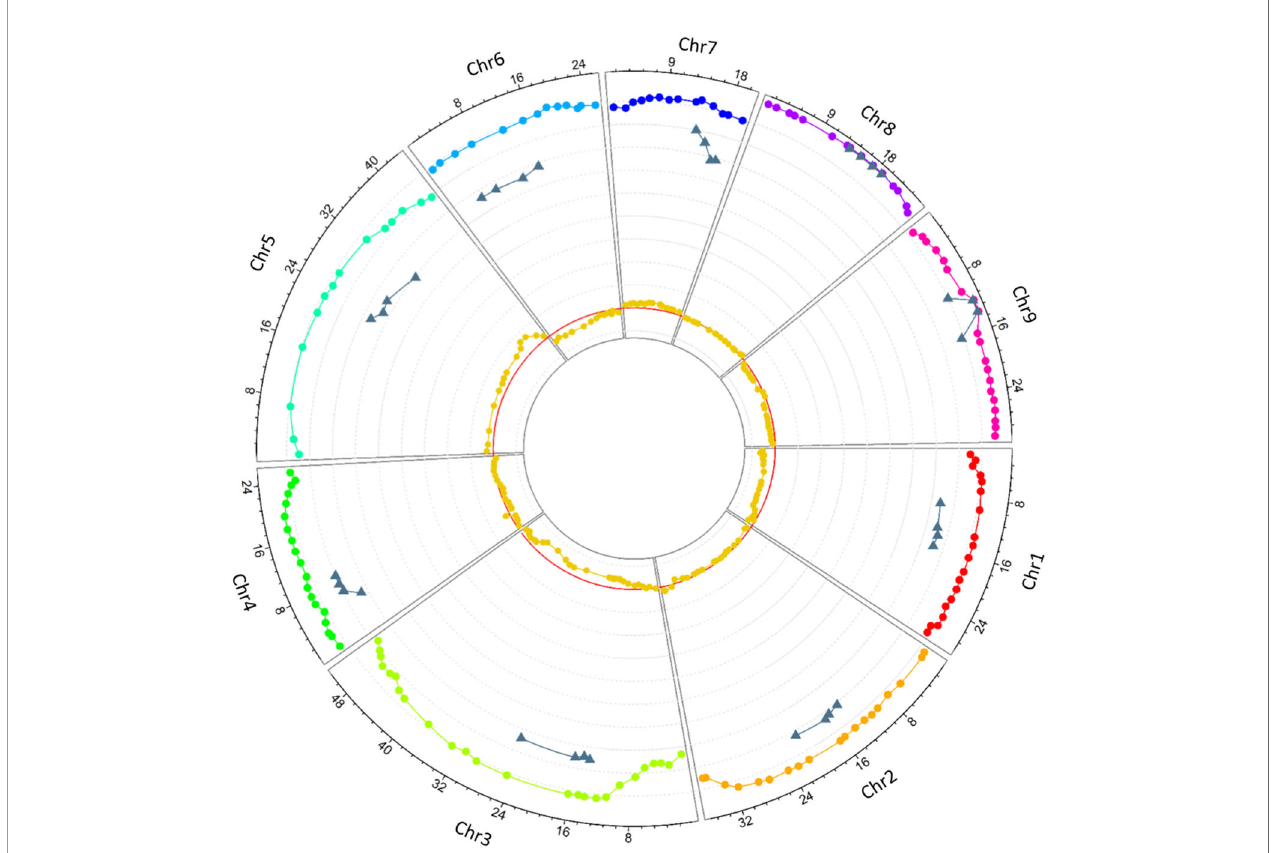
FIGURE 4 | Circos plot of the heterozygosity rates of diploid gametes along the nine chromosomes (rainbow colors represent the nine chromosomes), the preferential pairing rates computed in centromeric loci (gray), and deviation from the expected frequency of C. micrantha allele (dark yellow). The X-axis represents the SNPs physical positions (Mb), the y-axis ranges from − 0.1 to 1, each gray line stands for a unit; the red line stands for 0.